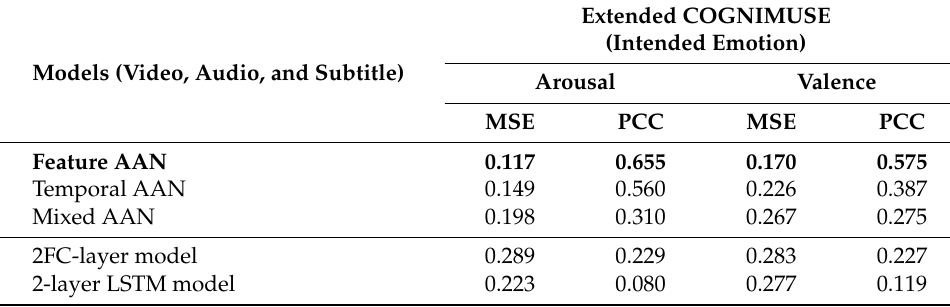
Table 5. The performance of our models using visual, audio, and text